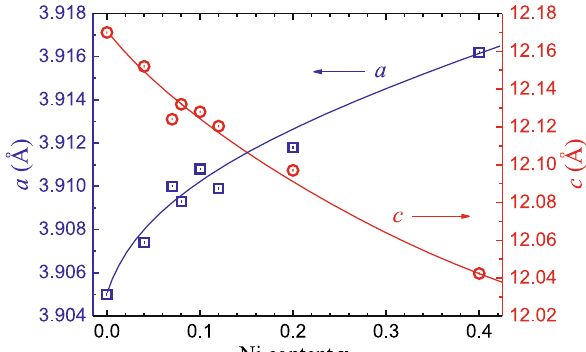
Figure 1. Lattice parameters of the tetragonal unit cell (space group I 4 /mmm ) at room temperature for obtained EuFe 2−x Ni x As 2 samples.